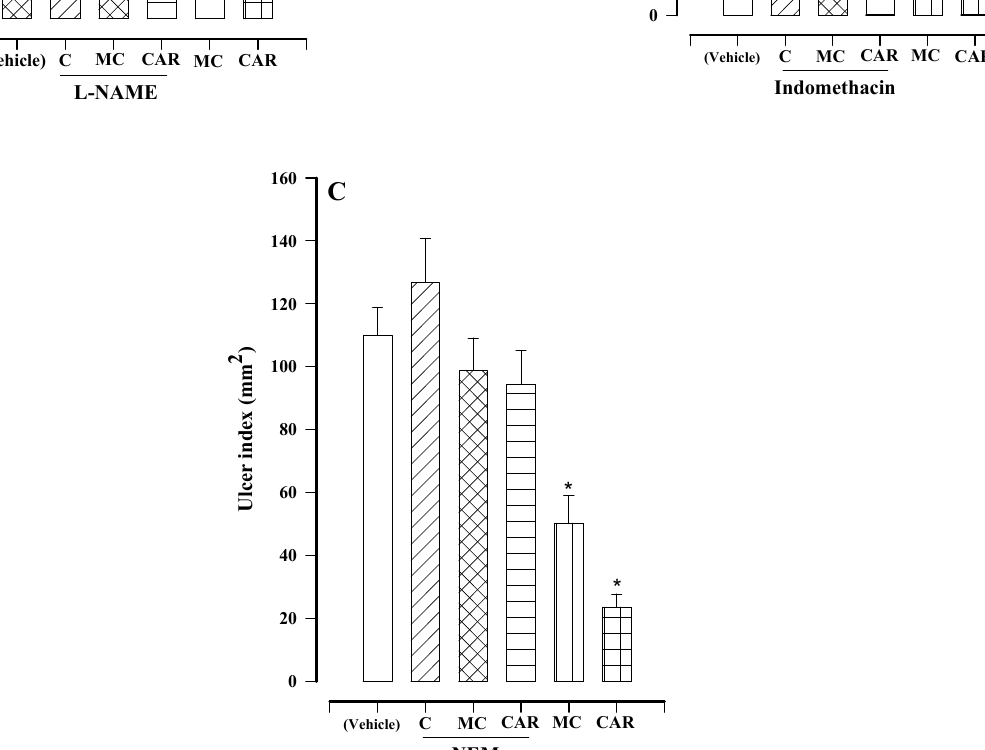
Figure 4. Regarding ethanol-induced gastric lesions in rats, the effects of two treatments are shown, the white solid (fractions 227–256 of F1) and carbenoxolone, each administered after one of three pretreatments: ( A ) L-NAME (70 mg/kg), ( B ) indomethacin (10 mg/kg), or ( C ) NEM (10 mg/kg). Bars represent the mean ± SEM ( n = 7). * p < 0.05 vs. the respective control, based on the Kruskal–Wallis test, followed by Dunn’s multiple comparison. C = control inhibitors, MC = the mixture of compounds (the white solid), and CAR = carbenoxolone.